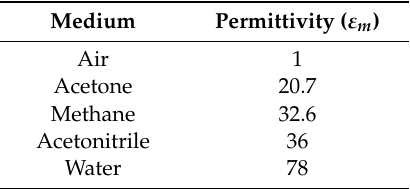
Table 3. Known values of permittivity’s of di ff erent mediums.